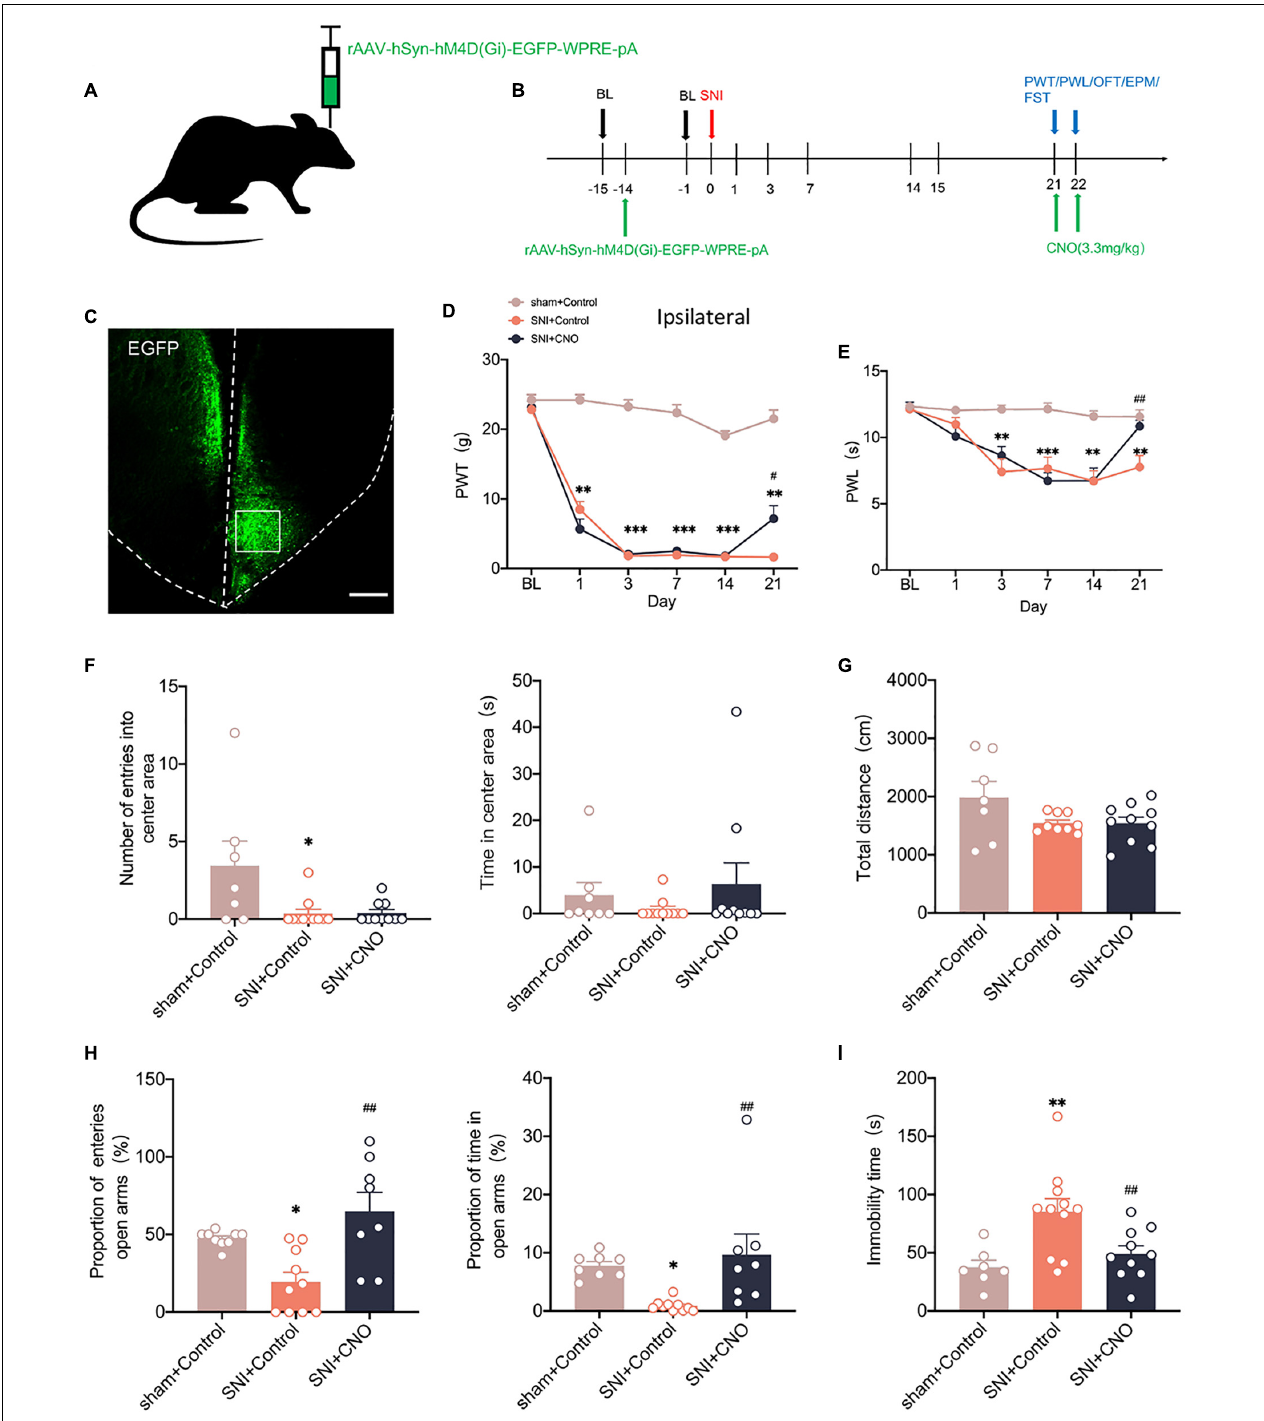
FIGURE 3 | Silencing the ACC by chemicalgenetic techniques reduced neuropathic pain and anxiodepression like behaviors. (A,B) Injection of rAAV-hSyn-hM4D (Gi)-EGFP into the contralateral ACC of SNI rats (A) and experimental timing (B) . (C) Immunofluorescence showed that rAAV-hSyn-hM4D (Gi)-EGFP was injected into the ACC and was successfully transfected (Scar bar = 50 µ m). (D,E) Intraperitoneal injection of CNO (3.3 mg/kg) to silence ACC attenuated PWT (D) and PWL (E) in SNI rats ( n = 10 rats/group). (F,G) Intraperitoneal injection of CNO (3.3 mg/kg) to silence ACC did not influence the number of entries into the center area, the time in the center area (F) , or the total distance (G) in the OFT ( n = 10 rats/group). (H) Silencing ACC by intraperitoneal injection of CNO (3.3 mg/kg) increased the proportion of entries into the open arms and the proportion of time in the open arms in the EPM ( n = 10 rats/group). (I) Intraperitoneal injection of CNO (3.3 mg/kg) to silence ACC decreased the immobility time in the FST ( n = 10 rats/group). ∗ P < 0.05, ∗∗ P < 0.001, ∗∗∗ P < 0.0001 for sham + Control vs. SNI + Control; # P < 0.05, ## P < 0.001 for SNI + Control vs. SNI +